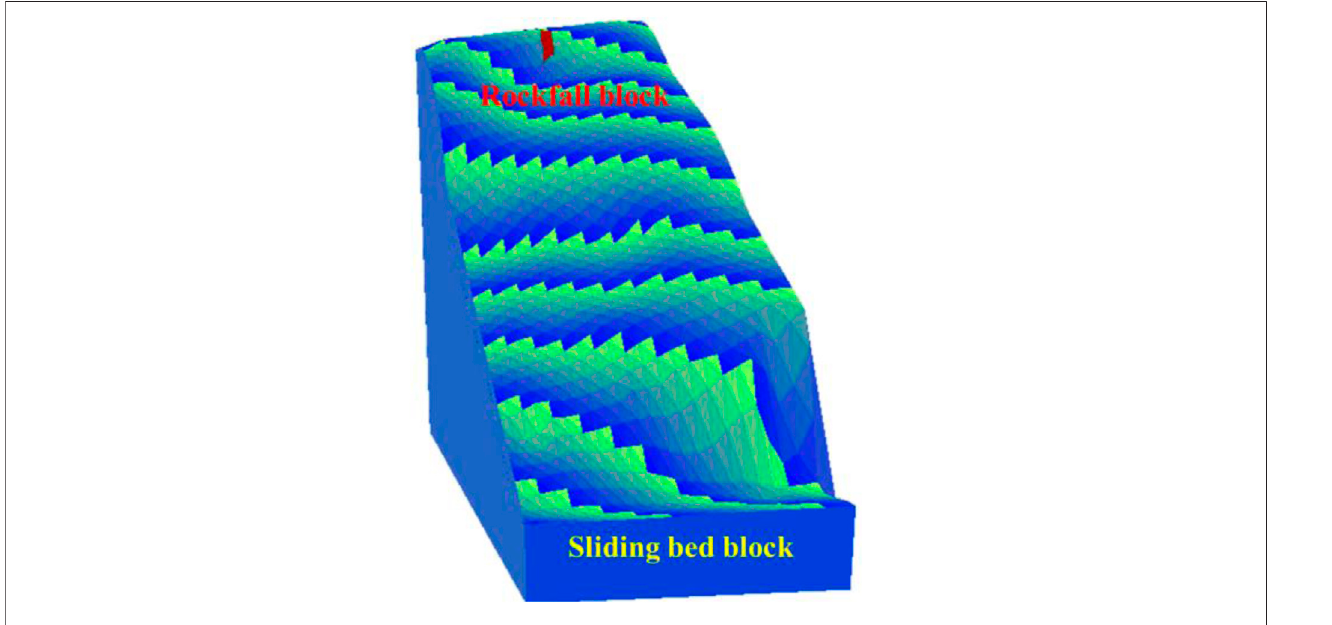
FIGURE 8 | A rockfall block